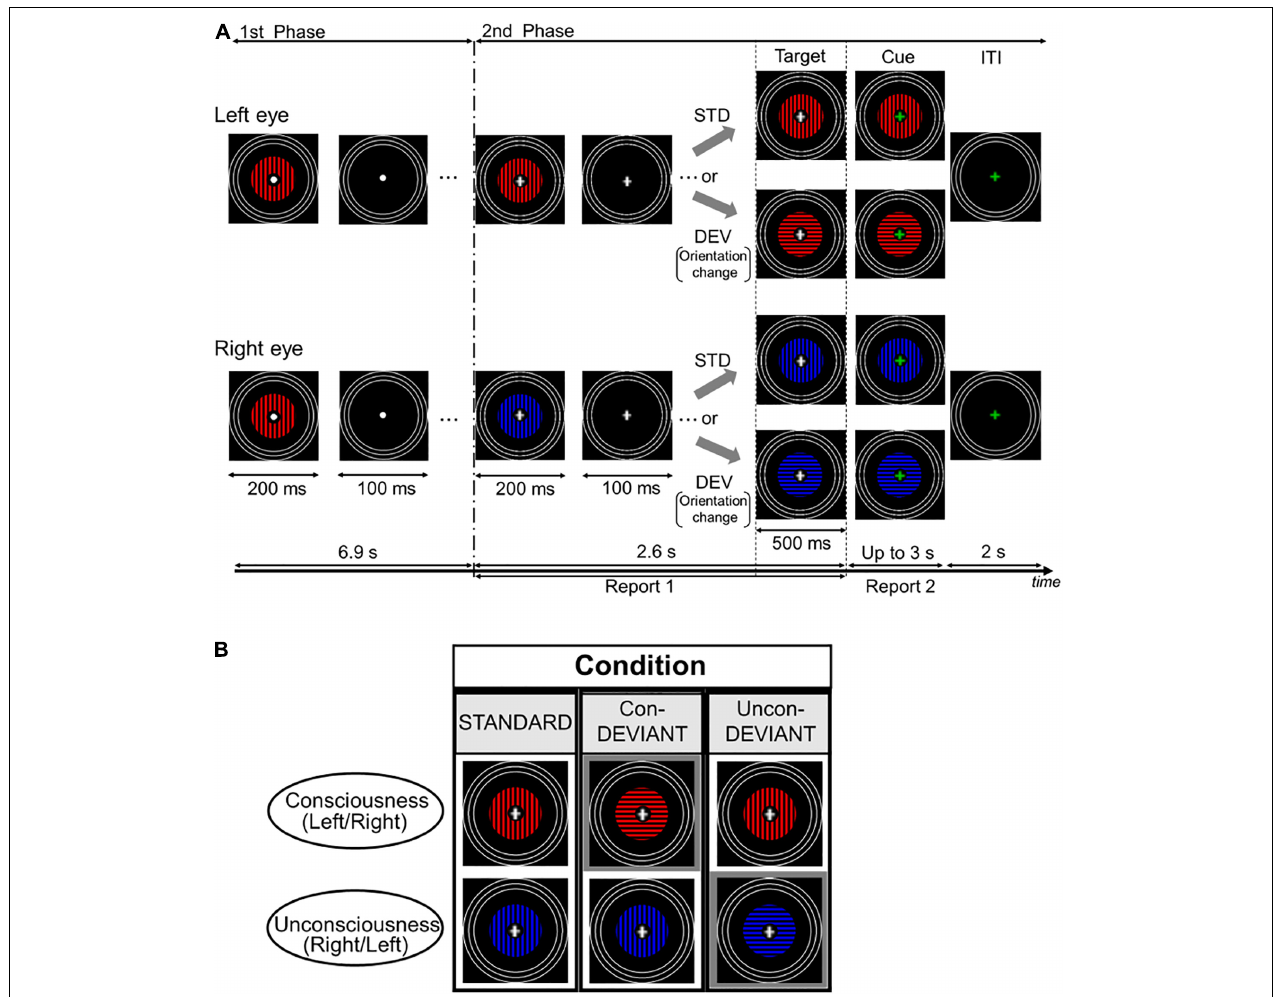
FIGURE 1 | Time course of stimulus presentation in one trial and experimental conditions. (A) Each trial consisted of two stimulation phases. In the first phase, an identical grating stimulus with a color (blue or red) was simultaneously and intermittently presented for both the left eye and the right eye. Participants were asked to passively look at the fixation point. In the second phase, a color of the grating stimulus changed for either of two eyes to induce the binocular rivalry (a color change from blue to red or vice versa), and the grating images were presented intermittently as in the first phase. During this phase, the fixation cross was continuously presented at the central area of the gratings, and participants were required to continuously report the perceived grating. Following the second phase, the target stimulus immediately appeared for 500 ms and its fixation cross then changed in color to a green cross (the cue). Participants were asked to report the current perceived grating stimulus after the onset of the cue. (B) Each pear of two grating stimuli arranged vertically indicates an example of target stimulus. Target stimulus had three variants by changing or not changing an orientation of the grating stimulus under the binocular rivalry. In the Uncon-DEV condition, an orientation of the grating stimulus which did not reach a conscious percept was exclusively changed by 90 ◦ . Meanwhile, in the Con-DEV condition, orientation of the grating stimulus which reached a conscious percept was exclusively changed by 90 ◦ . In the STD condition, there was no change of the grating stimulus for both